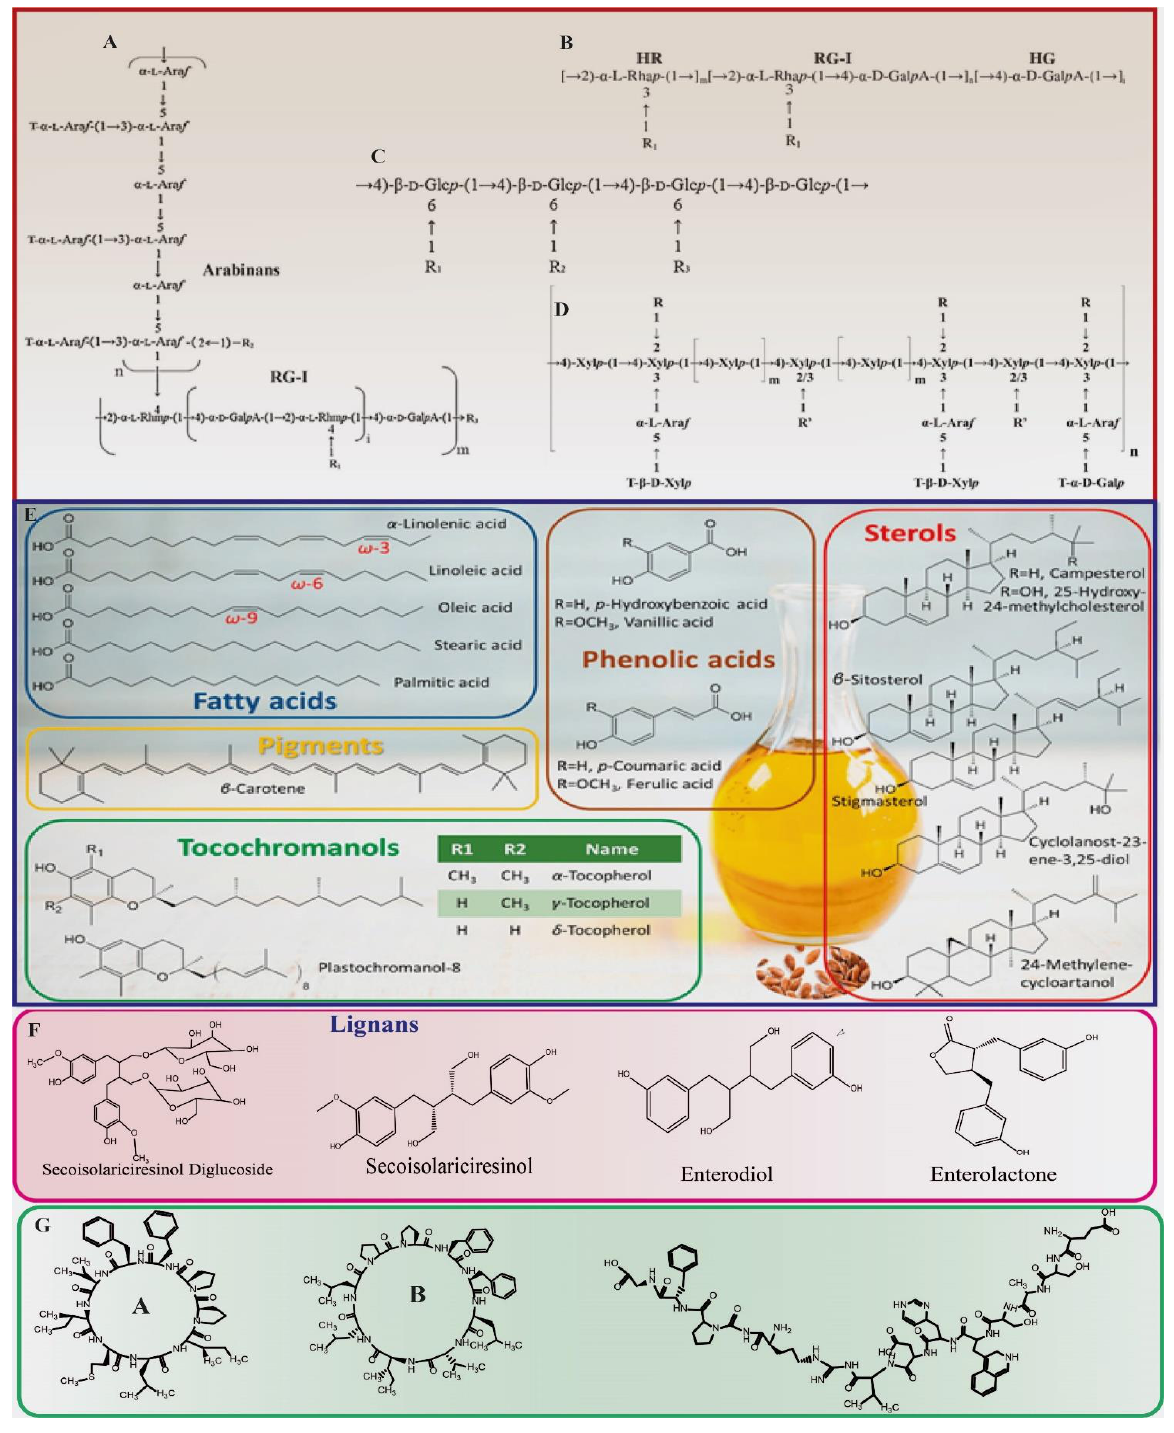
Figure 1. Overview of flaxseed bioactive compounds. ( A ) Proposed structure of KPI-ASF as RG-1 bridge-linked arabinans. ( B ) Proposed repeating unit of the acidic fraction gum (HR, RG-1, and HG refer to homorhamnan, rhamnogalacturonan-I, and homogalacturonan, respectively). ( C ) Proposed structure of KPI-EPF as xyloglucans. ( D ) Proposed structure of FM-NFG as arabinoxylans. ( E ) Flaxseed oil, phenolic acids, sterols, pigments, and tocochromanols. ( F ) Lignans and their metabo- lites. ( G ) Cyclolinopeptide-A, cyclolinopeptide-B, and alcalase-derived antioxidant